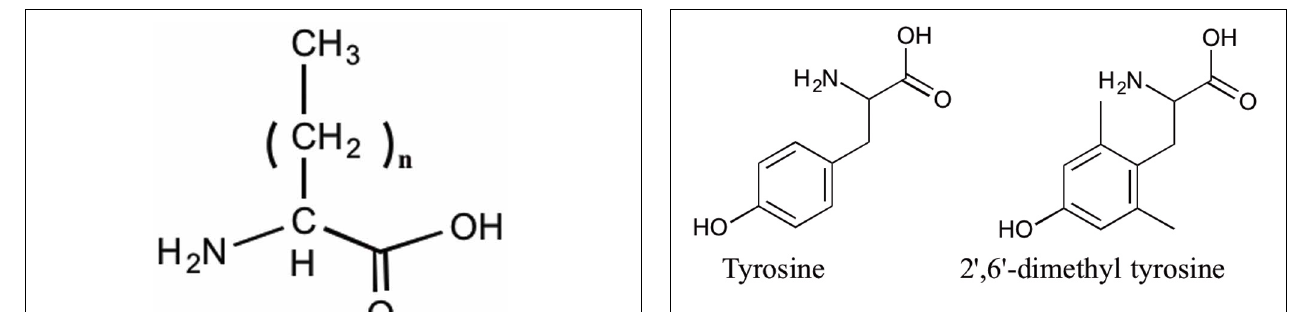
FIGURE 4 | Structure of Tyrosine and 2 (cid:2) ,6 (cid:2) -dimethyltyrosine. modified peptides with/without substitution of Tyr 1 with Dmt